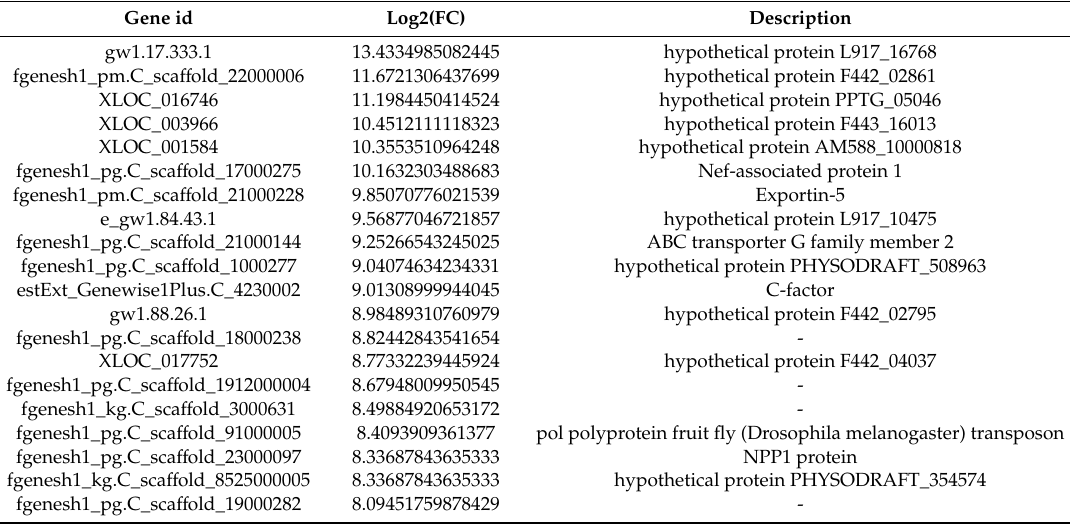
Table 6. Top 20 upregulated genes of P. capsici